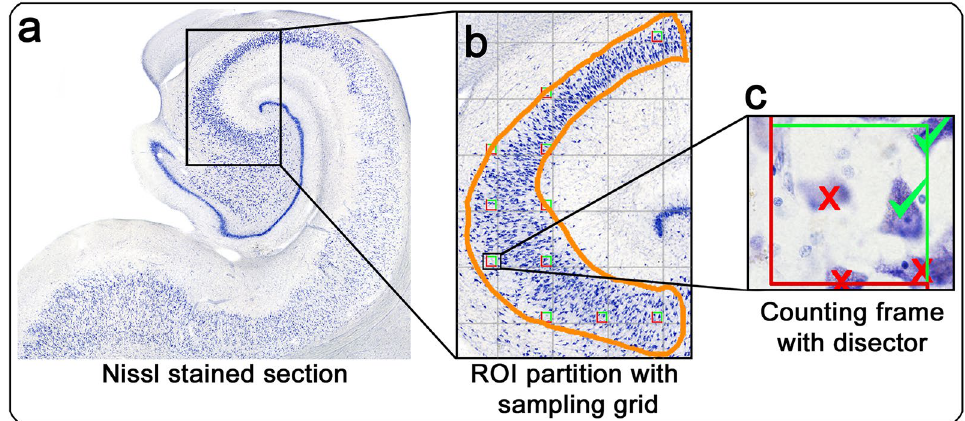
Figure 3. Manual hippocampal pyramidal neuron counts using optical fractionator stereology and systematic random sampling: ( a ) Nissl stained section with inset showing CA3 (example ROI). ( b ) ROI was outlined with random sampling grid overlaid and resulting with approximately 10 counting frames per the ROI. ( c ) 50 µm × 50 µm counting frame showing exclusion (red) and inclusion (green) lines. Tissue thickness taken by focusing from top to bottom of the section and averaged 20.3 µm across partitions. ROI region of